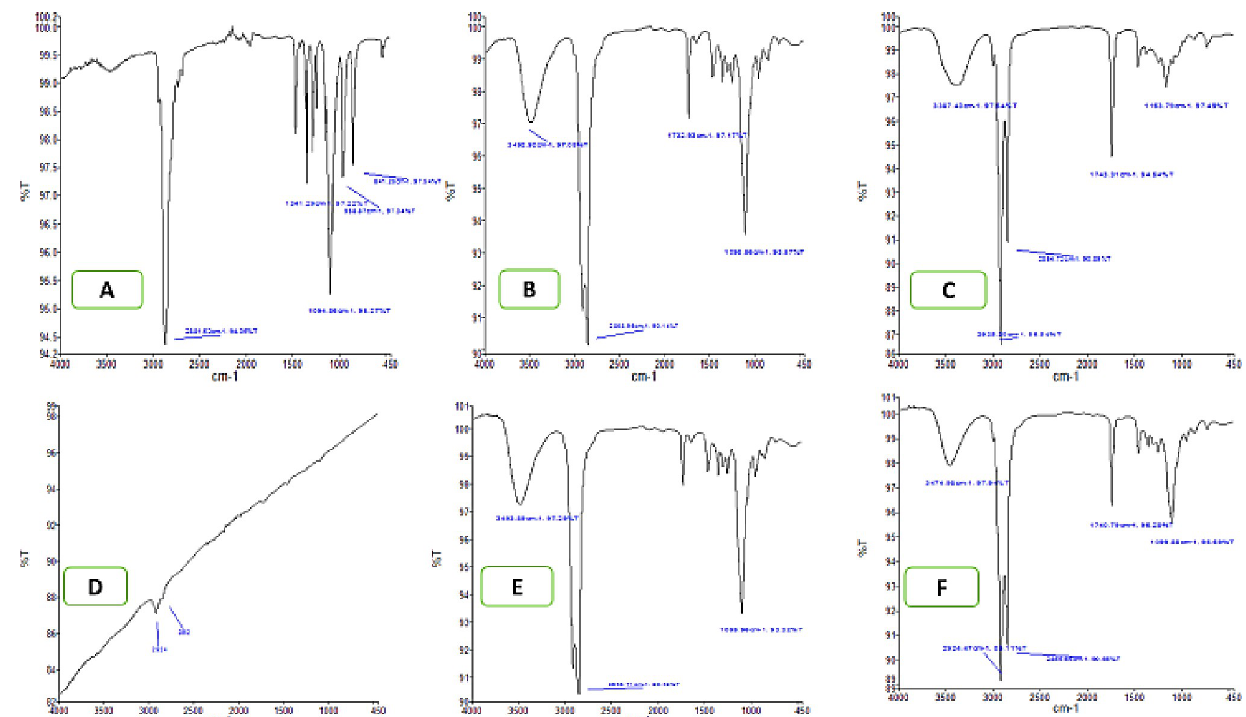
Fig 4. FTIR Spectra of (A) PEG 400, (B) Cremophor EL (C), castor oil (D), Iodine, (E) HPMC and (F) Iodine SNEDDS.